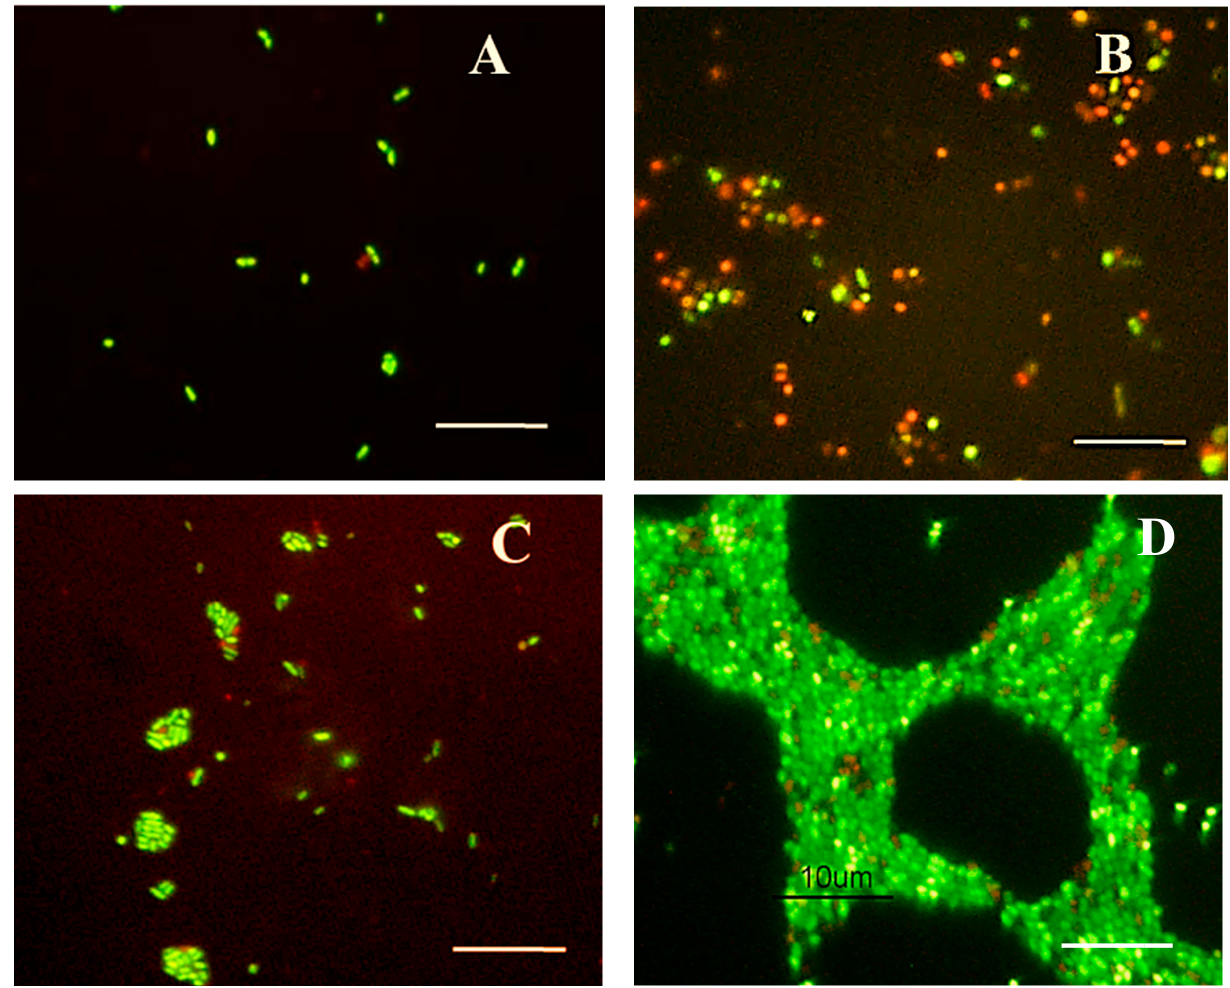
Figure 4. Morphological changes of Edwardsiella cells maintained under starvation conditions. ( A ) Viable bacillary cells in 2-day-old microcosms (10 µL were used for LIVE/DEAD staining); ( B ) Vi- able and non-viable rounded cells, and viable bacillary cells in 4-week-old microcosm; ( C ) Viable and non-viable rounded cells, and aggregates of viable bacillary cells observed in 10-week-old mi- crocosm; ( D ) Biofilm composed primarily of short rod-shaped viable cells in 20-week-old micro- cosm. Bars = 10 µm.